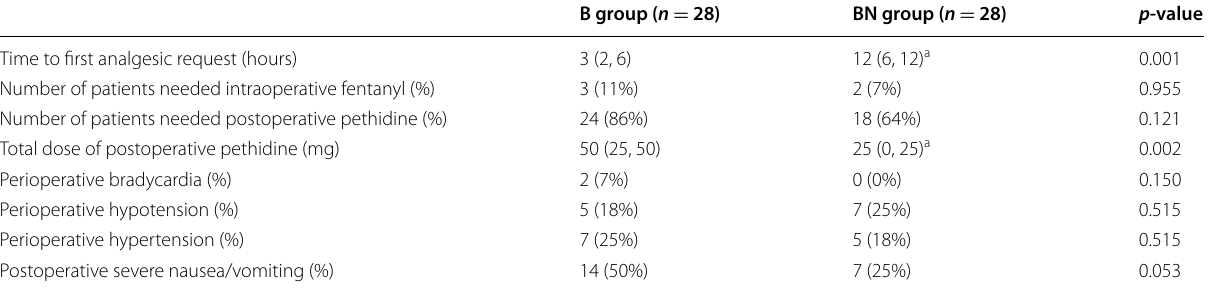
Table 2 Perioperative analgesic requirements and hemodynamic characteristics. Data presented as median (quartiles) and frequency